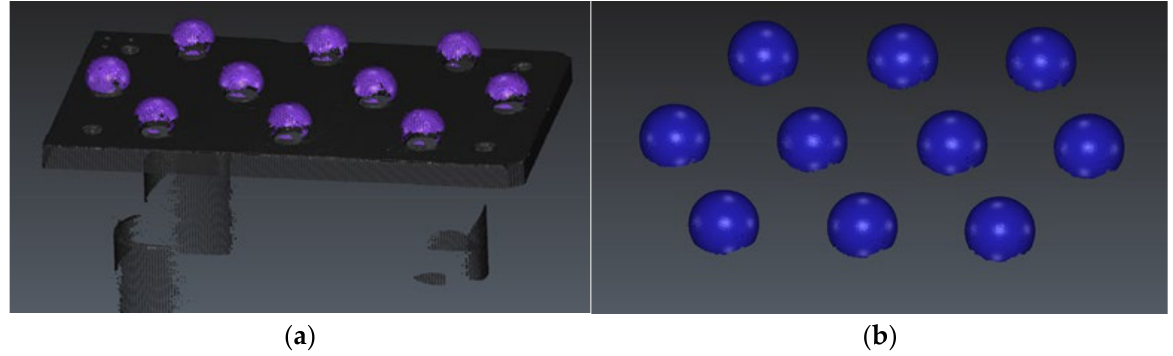
Figure 9. ( a ) Point cloud digitised by the laser sensor Hexagon HP-L-10.6. ( b ) Point clouds corre- sponding to the different spheres after cleaning and